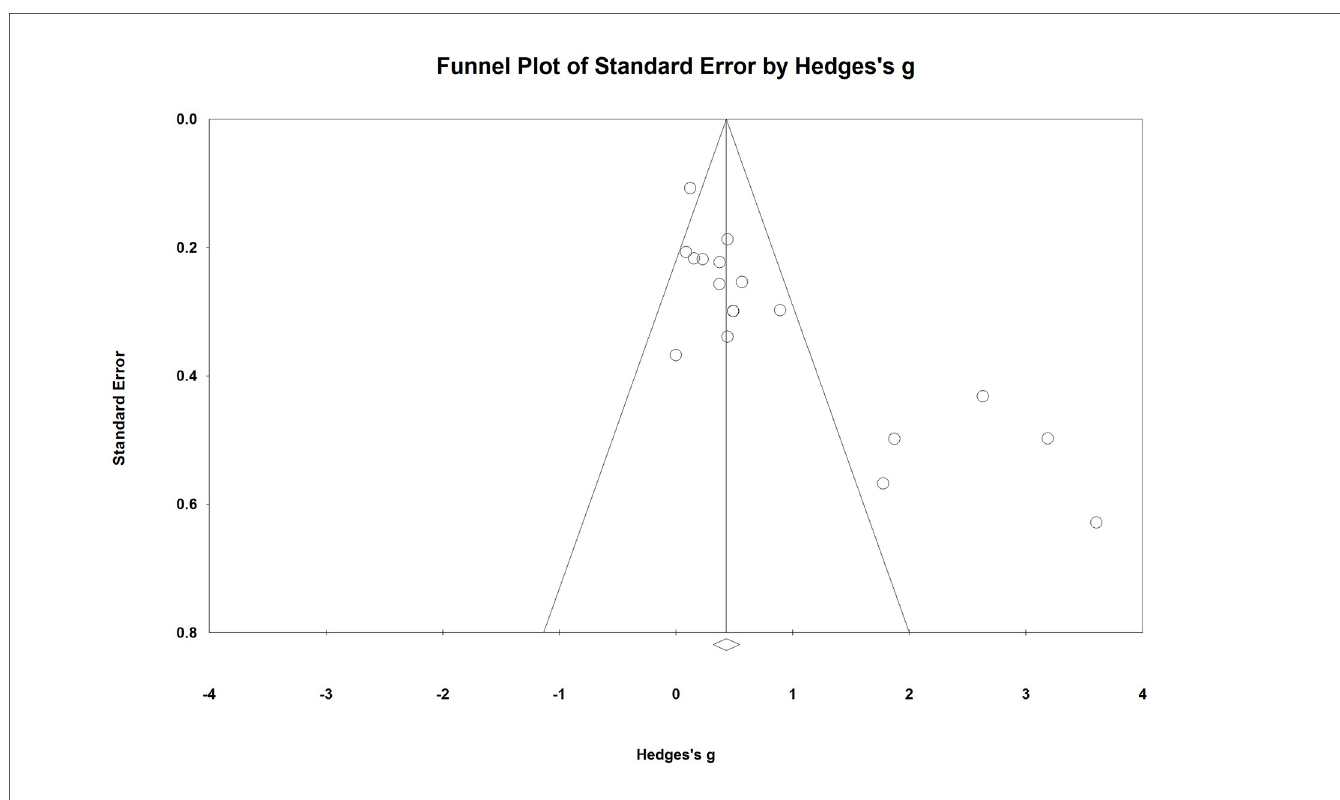
Fig 4. Funnel plot of standard error by Hedges’